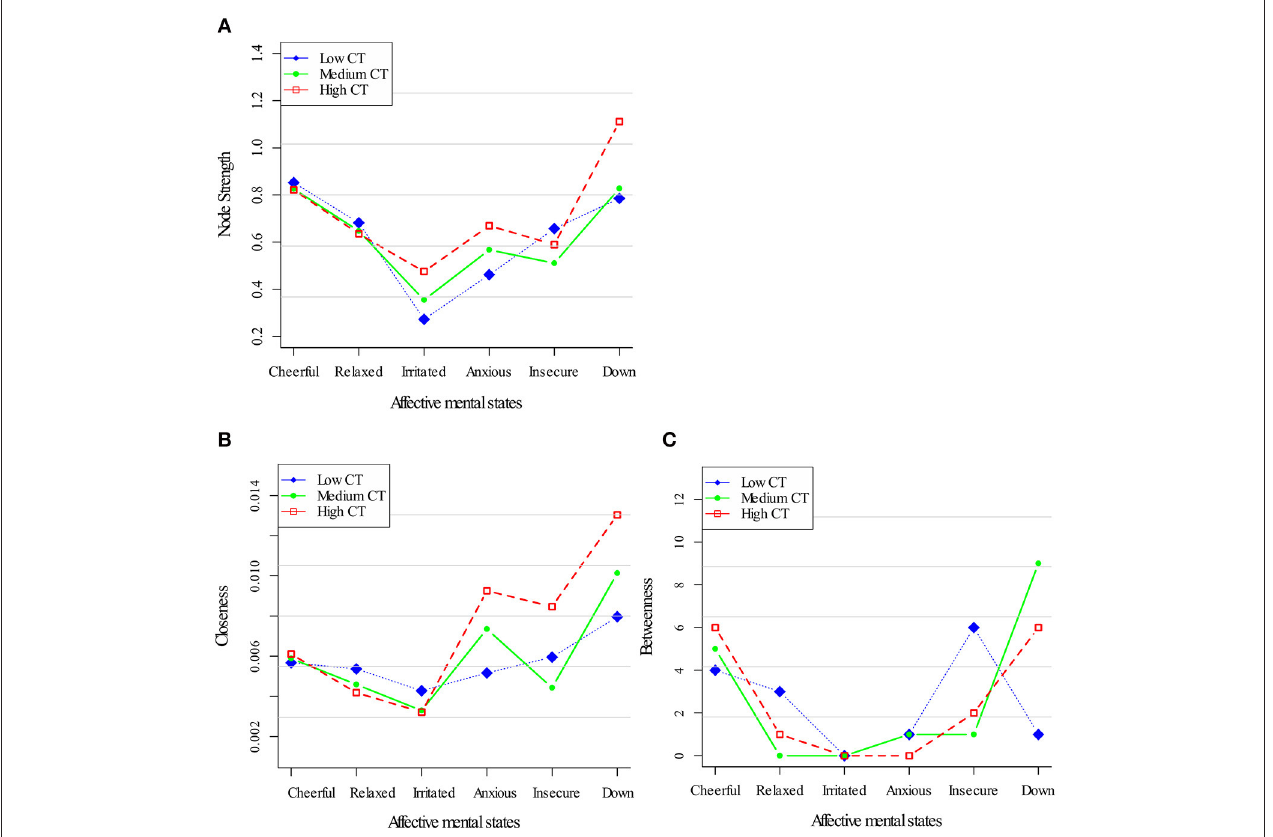
FIGURE 2 | Centrality measures for the childhood trauma exposure networks. Three node centrality measures: Node Strength (A) , Closeness (B) , and Betweenness (C) , of low, medium, and high levels of childhood trauma exposure.